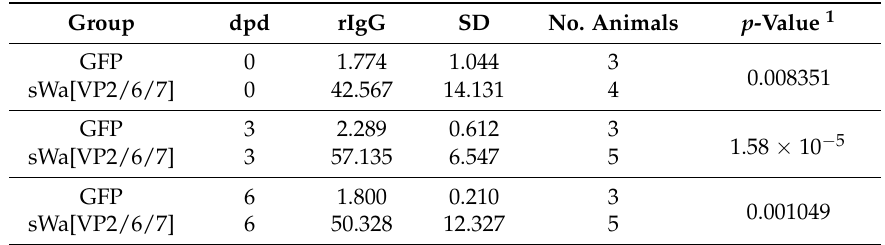
Table A2. This table displays all data used to generate Figure 3C as well as the number of animals included in this study and the p -values.